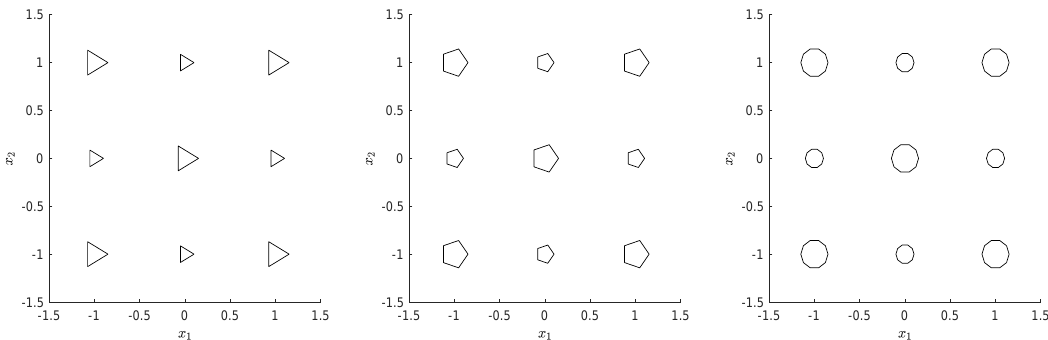
Figure 3. Local Pareto set regions of the DBMOPP problems generated for k = 3,5,10 objectives.